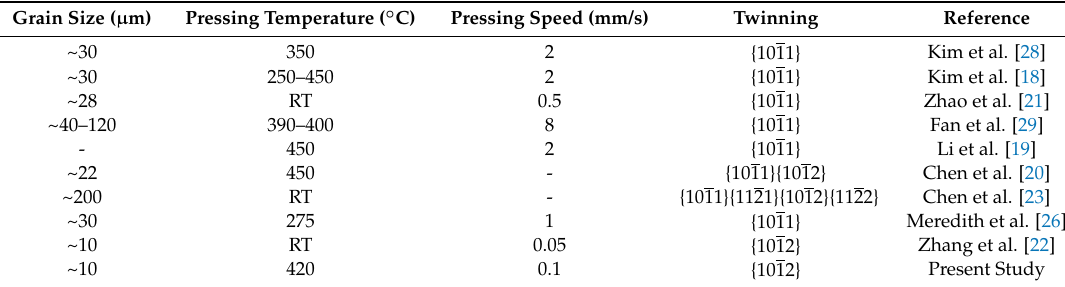
Table 1. List of different twinning modes of CP Ti after one pass of